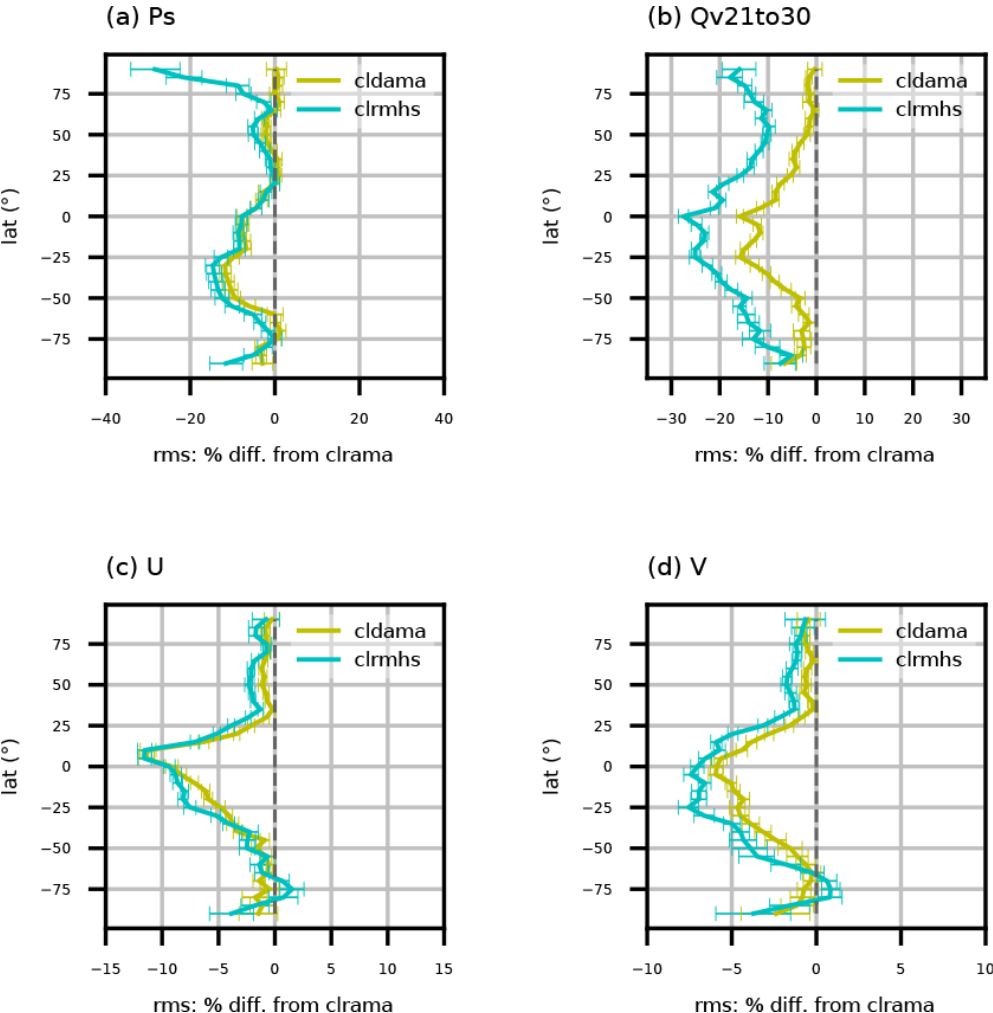
Figure 7. Similar to Fig. 6 but for latitudinal variations of RMSE reduction for (a) surface pressure, (b) water vapor mixing ratio of model level 21 to 30, and the whole-column (c) zonal wind and (d) meridional